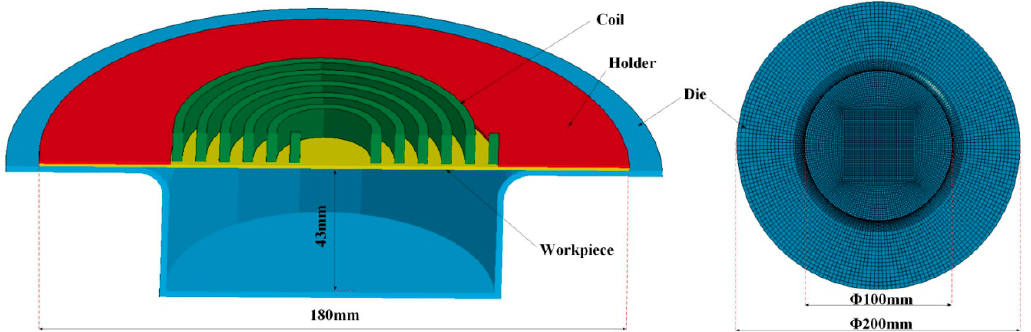
Figure 21. Void evolution in different positions.